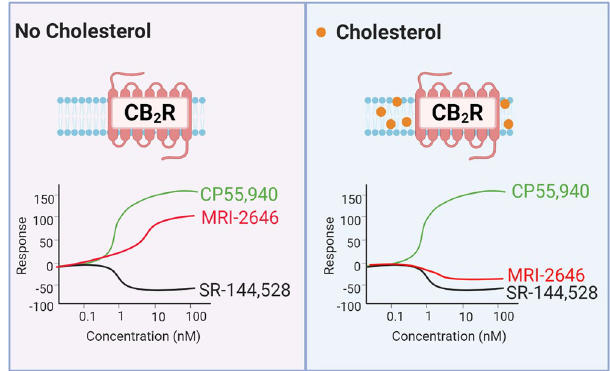
Figure 11. Membrane cholesterol dependent protean